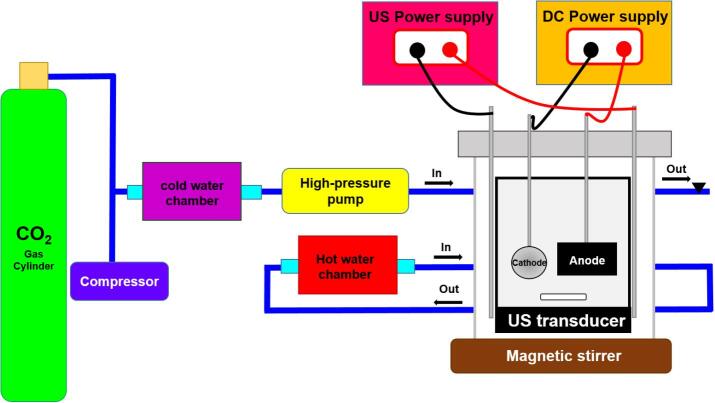
Schematic representation of high-pressure experimental arrangement.